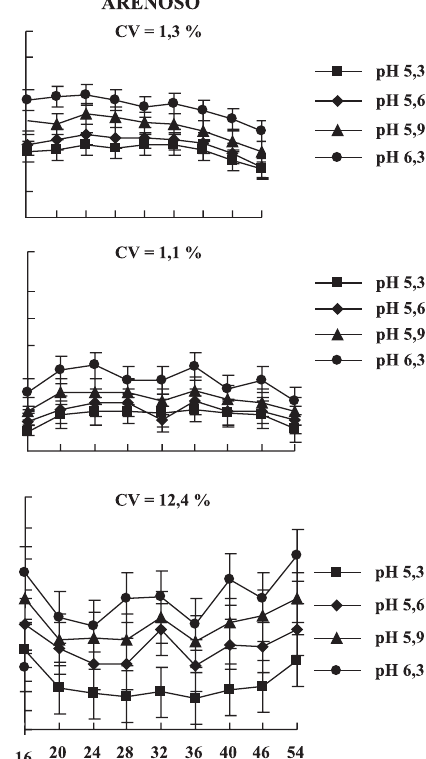
), no pH do solo entre r - pH ) em diferentes épocas de s r